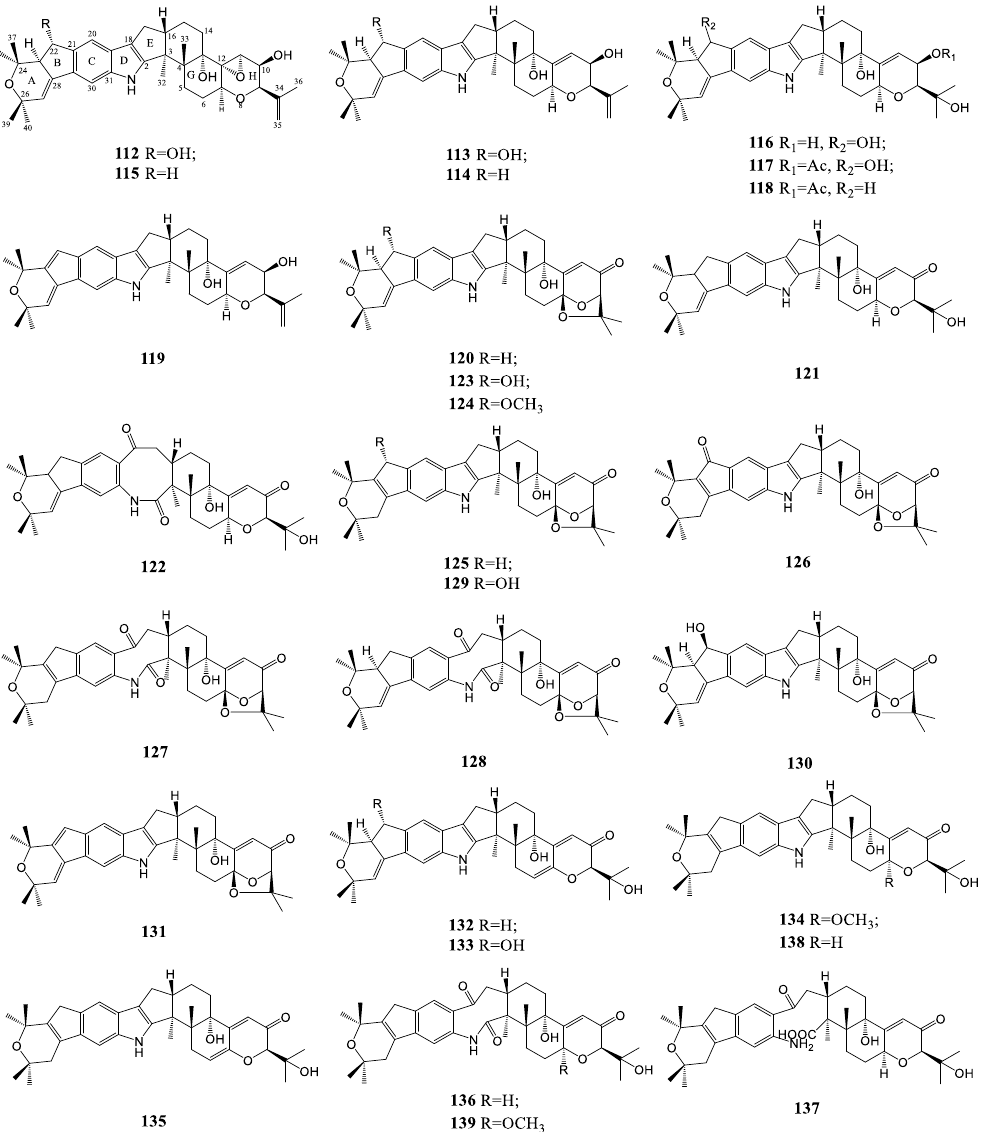
Figure 6. Janthitrem/shearinine-like indole diterpene compounds.